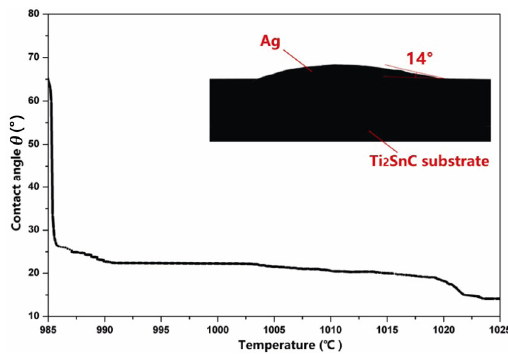
Fig. 1 Contact angle of Ag on Ti 2 SnC substrate from 985 to 1025 ℃ and the image of the minimum contact angle (~14°) at 1025 ℃ (the